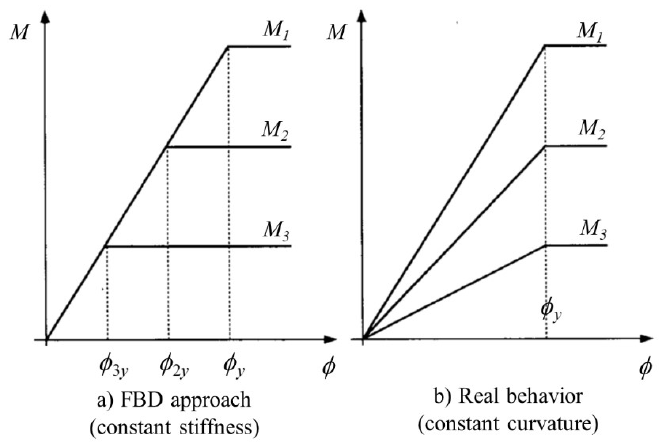
Figure 1. Influence of strength on the moment–curvature response ( a ) constant stiffness, and ( b ) constant curvature approaches [6,7].